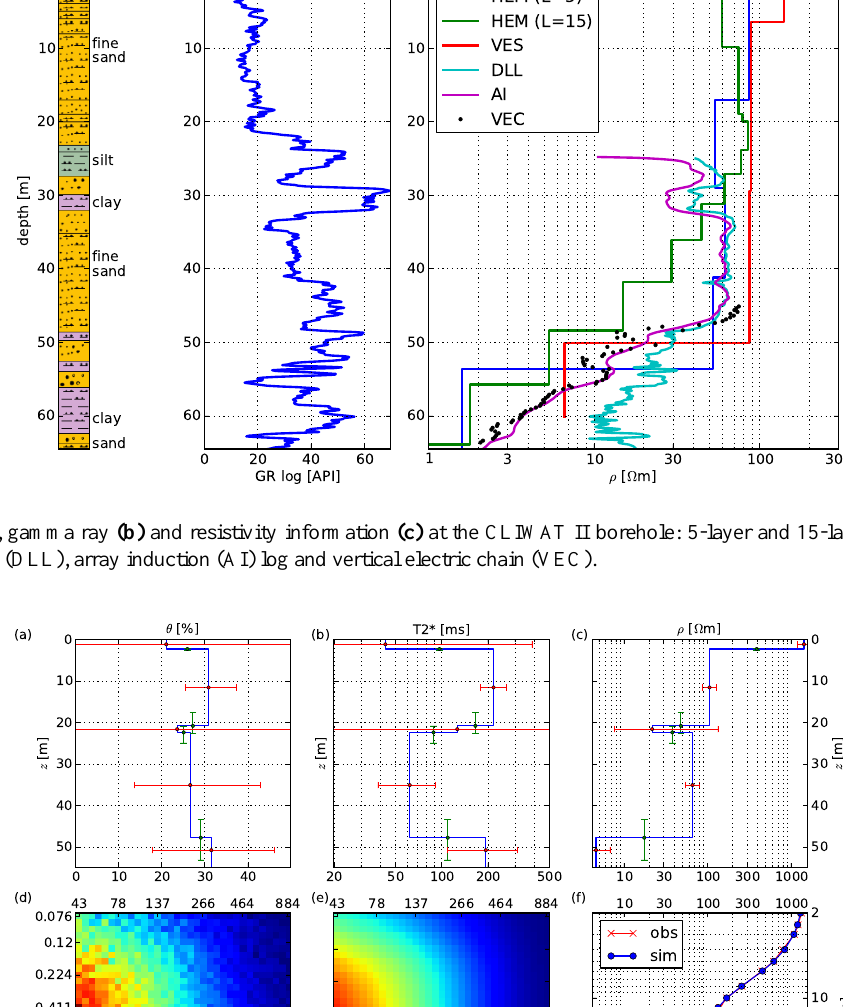
distinguished due to the bad resolution below 50 m, the good conducting